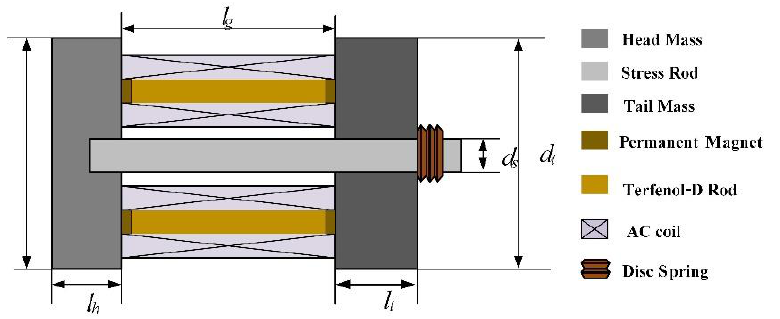
Figure 1. Cross-section view of the Tonpilz Terfenol-D .